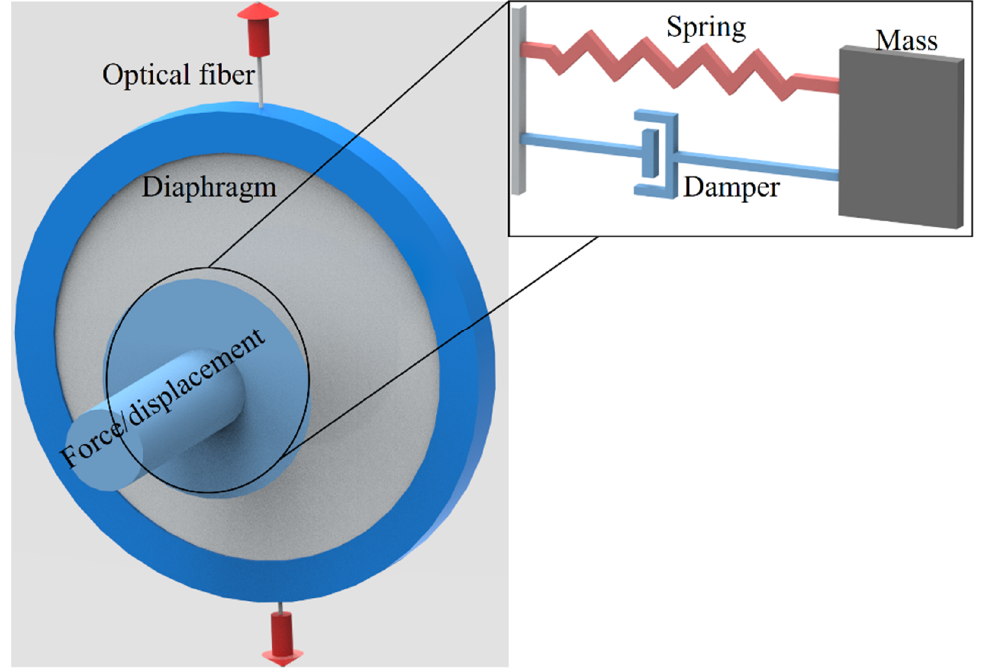
Figure 1. Schematic representation of force transmission. Figure inset shows the spring–mass– damper representation.